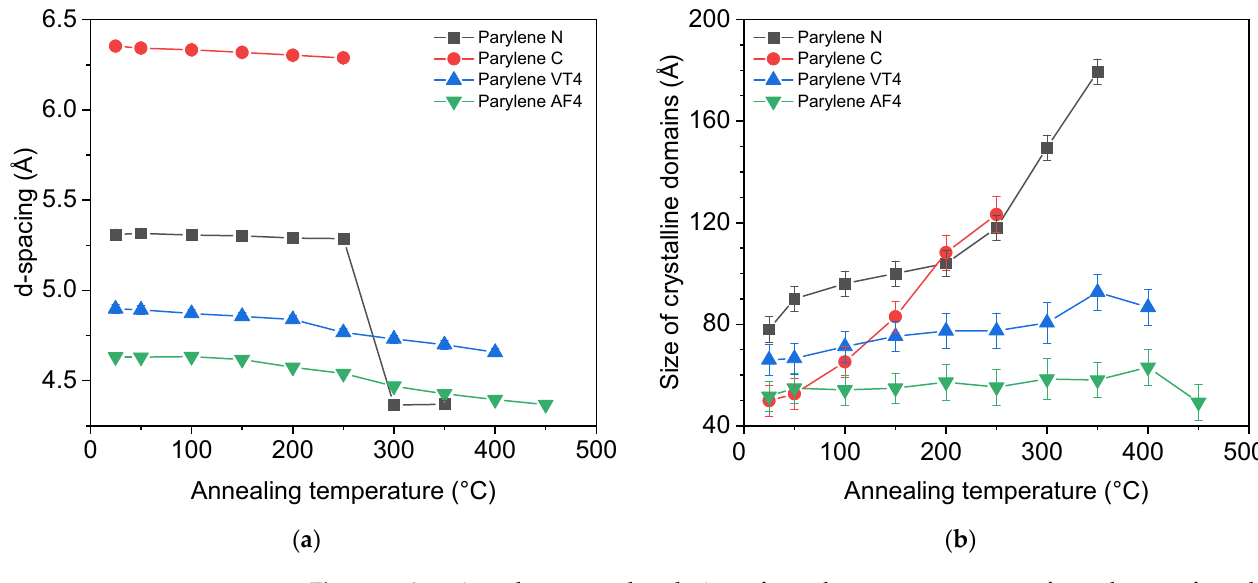
Figure 4. Atomic-scale structural analysis performed at room temperature for each type of parylene: ( a ) the d-spacing (Å) as a function of the annealed temperatures; ( b ) the size of the crystalline domains (Å) as a function of the annealed temperatures.